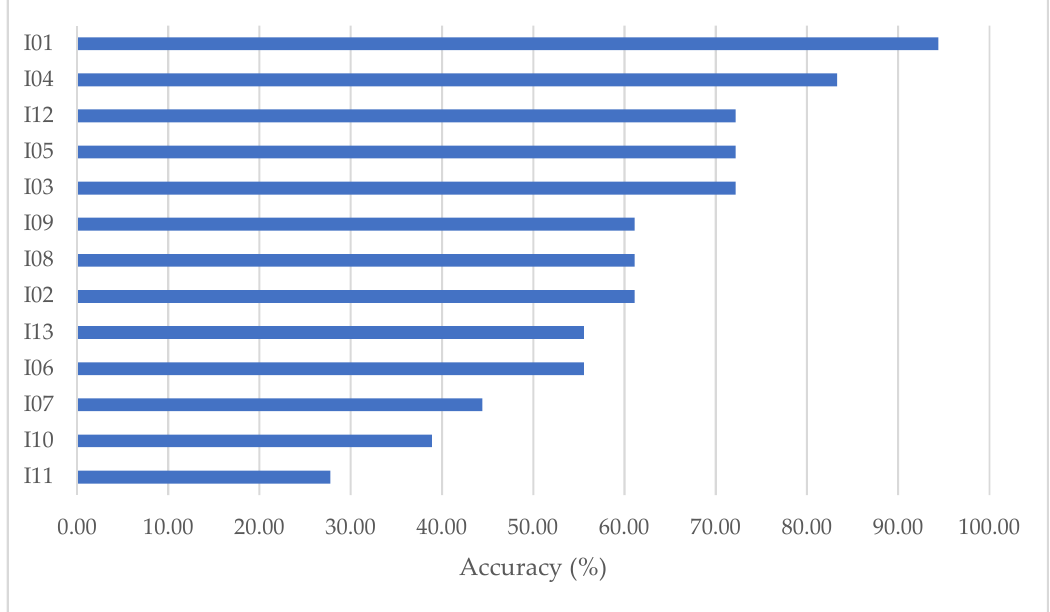
Figure 4. Percentage of accurate responses in all tasks combined by Inuktitut-English bilinguals.